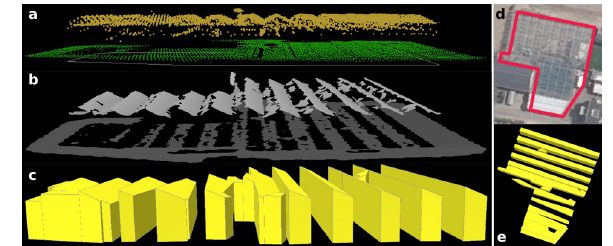
Figure 3 . LoD2.2 reconstruction of a greenhouse is difficult a) AHN3 point cloud (green: surface points; brown: building points). b) 2.5D height surface with maximum height for each pixel c,e) LoD2.2 reconstruction result. d) aerial image and Figure 2 . Examples of overlapping and underground BAG- polygons (red). Aerial images 2020 25cm RGB open data © Het Waterschapshuis.